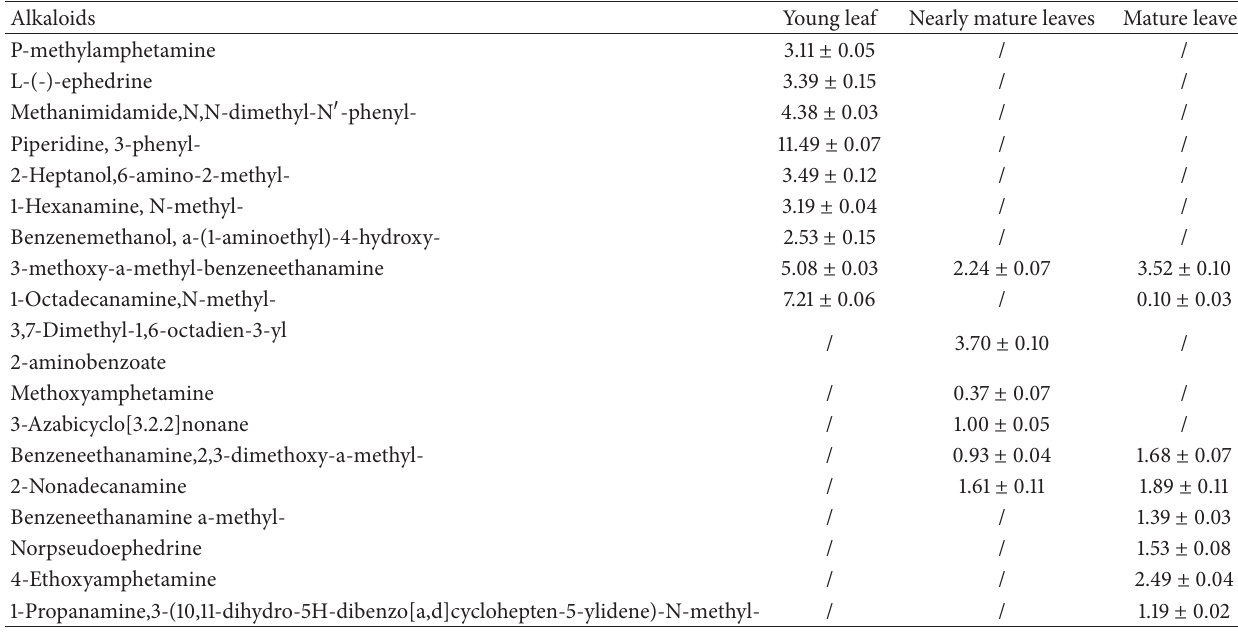
Table 2: Content of alkaloids in different developing stages of leaves of Thymus quinquecostatus . Alkaloids Young leaf Nearly mature leaves Mature leaves